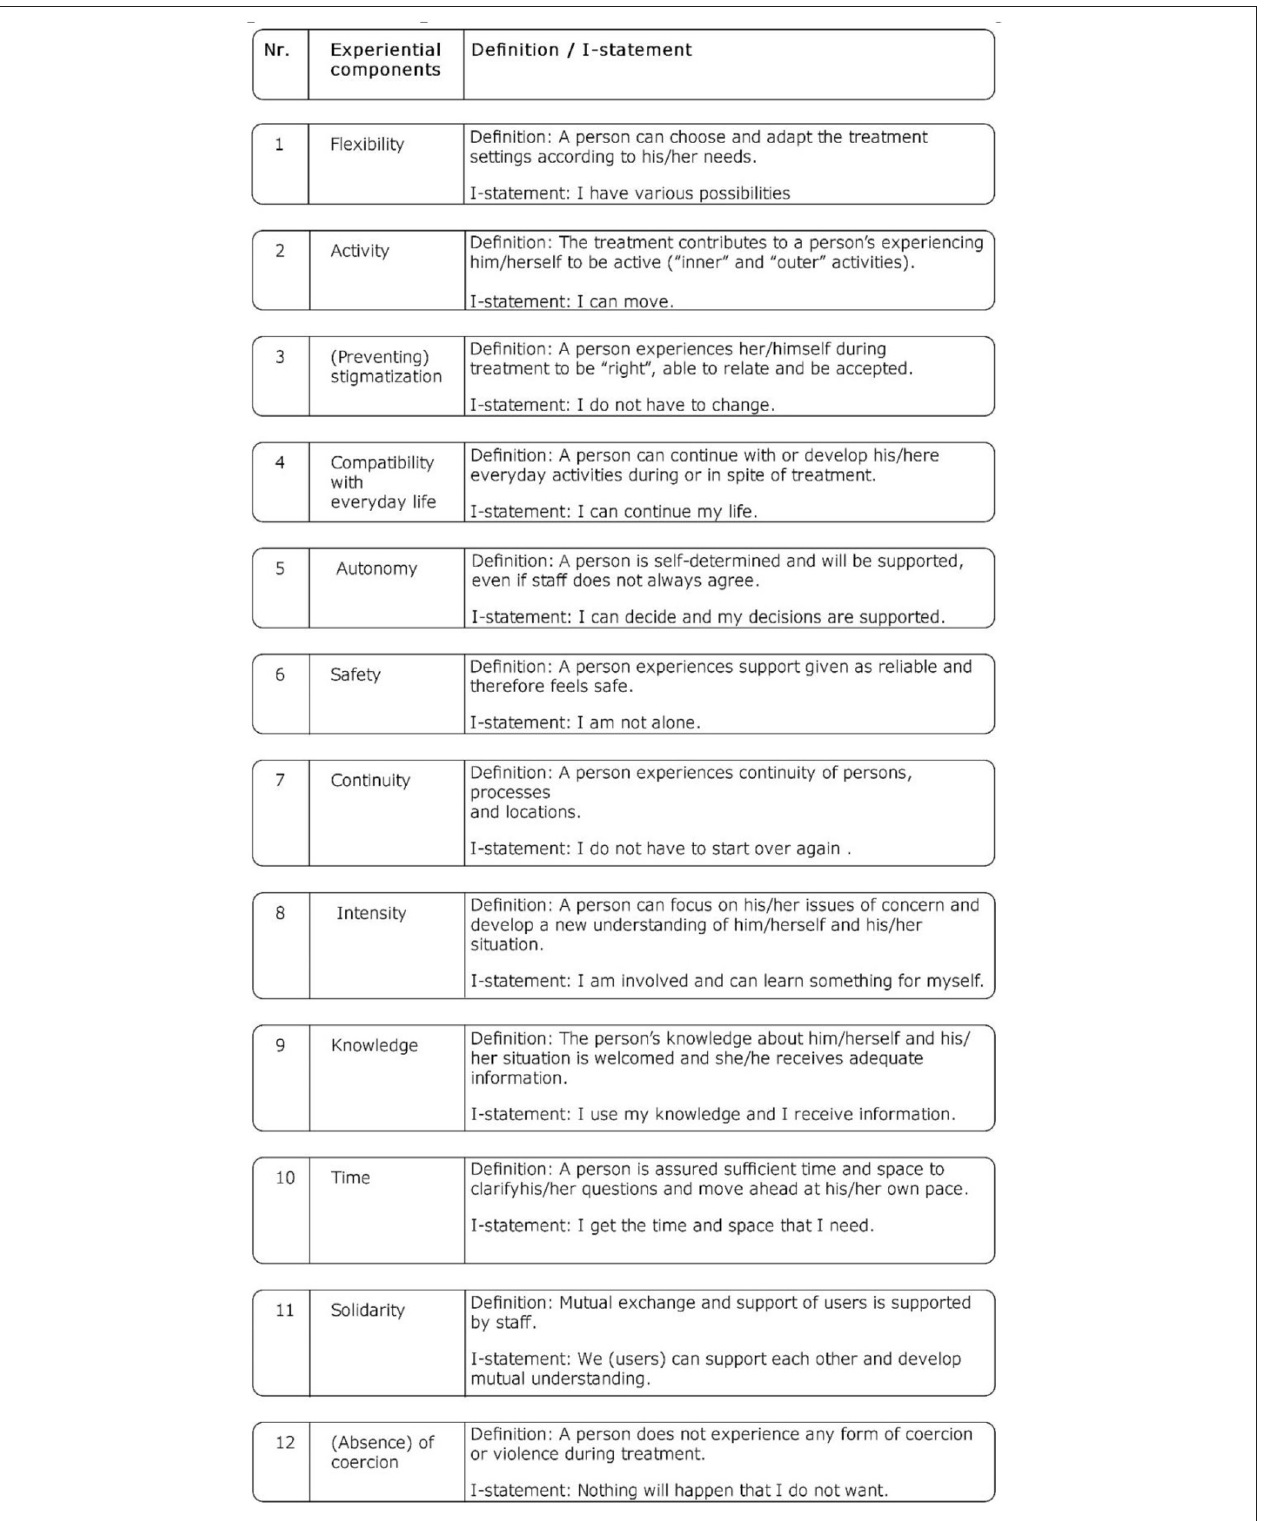
FIGURE 2 | The developed 12 experiential components that reflect the experiences and fulfillment of needs of psychiatric treatment from the perspective of service users. To this end, they were framed as I-statements and their definitions were given accordingly.